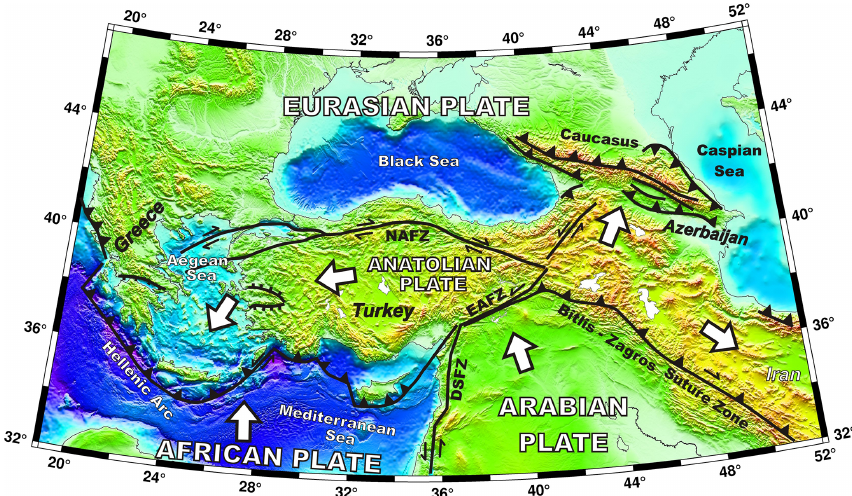
Figure 1. Simplified tectonic map of the eastern Mediterranean. DSFZ: Dead Sea Fault Zone; EAFZ: East Anatolian Fault Zone; and NAFZ: North Anatolian Fault Zone. Triangles indicate the direction of vergence or subduction. Bars are the down-thrown side of normal faults. White arrows are relative plate motions. The relief model is generated with the ETOPO1 model (Amante and Eakins, 2009).